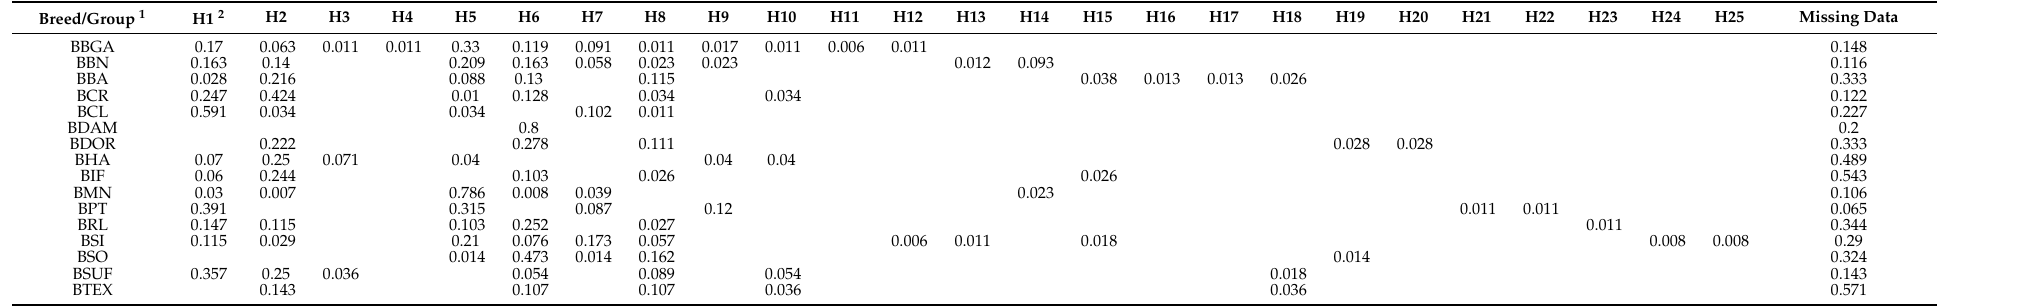
Table 2. TMEM154 haplotype frequencies of Brazilian sheep generated by 9 SNPs with the Fluidigm methodology. Breed/Group